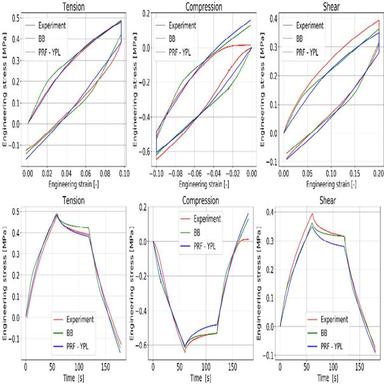
omparison of experimental and predicted curves for strain rate 0.1 s-1.